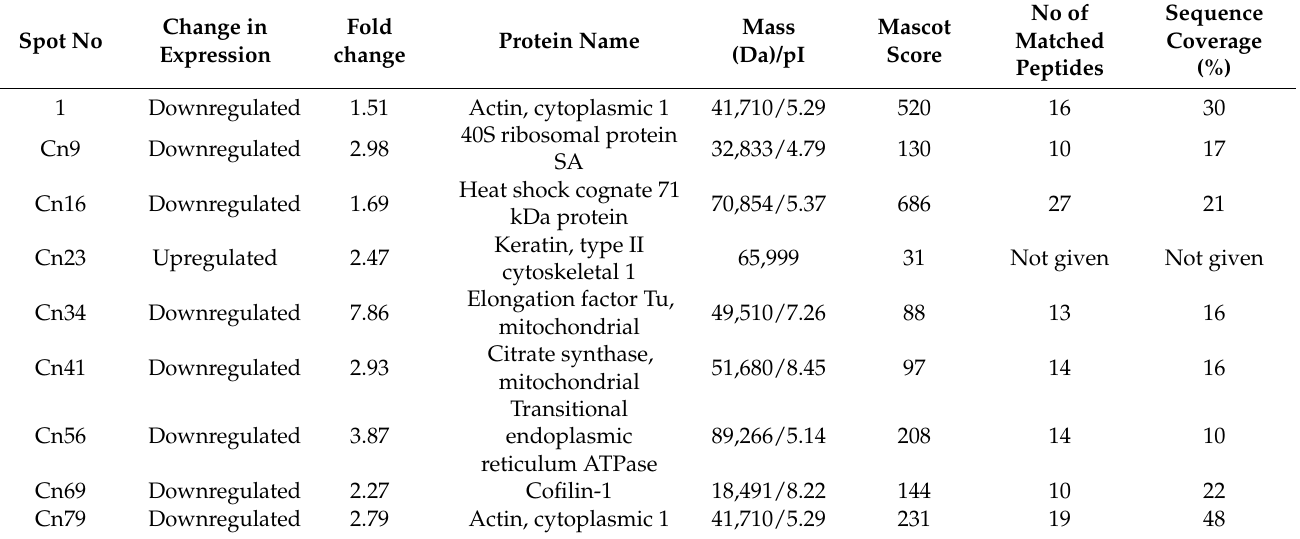
Table 3. Protein spots that underwent significant changes in expression after treatment with NH3 alone in A2780 cisR cell line and their identification (name, mass, Da/pI, mascot score, matched peptides, percentage of sequence coverage).